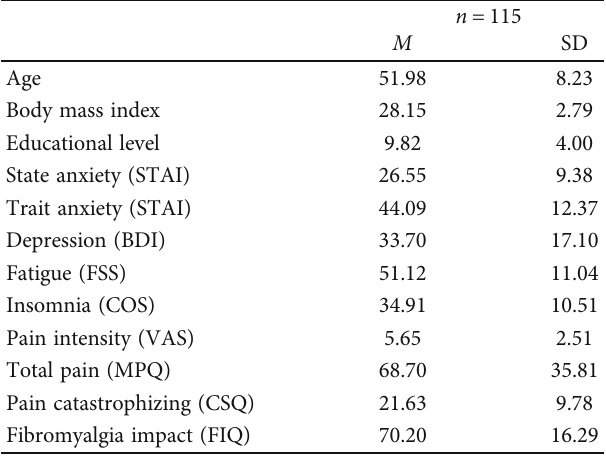
Table 1: Mean ( M ) and standard deviation (SD) of participants ’ demographic and clinical